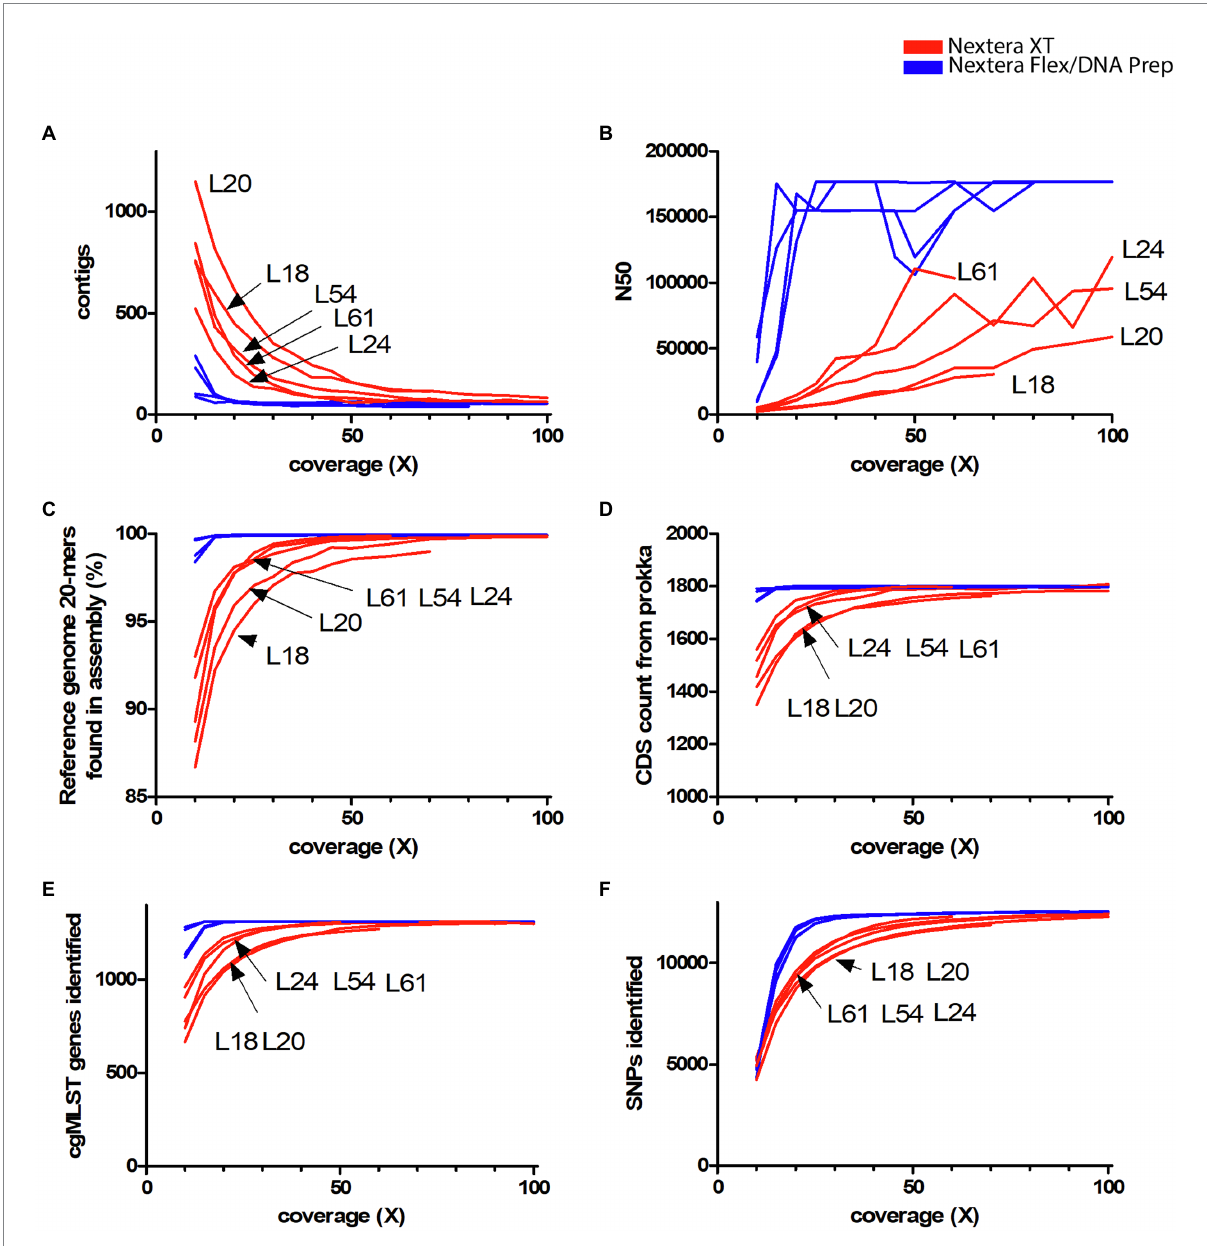
FIGURE 1 Dependency on the total amount of data used for quality parameters in the Campylobacter jejuni PT 28 dataset. The data have been colored to indicate the type of library prep kit used (Nextera XT red, Nextera Flex/DNA Prep blue). (A) The number of contigs generated by SPAdes assembler after filtering short and low coverage contigs. (B) N50 values of the assemblies. (C) The percentage of the k -mers present in the completed reference sequence found in the assemblies. (D) Number of genes found by the annotation tool Prokka. (E) Number of cgMLST genes (Oxford schema) called by Ridom SeqSphere+. (F) Number of SNPs called by Snippy against the reference genome